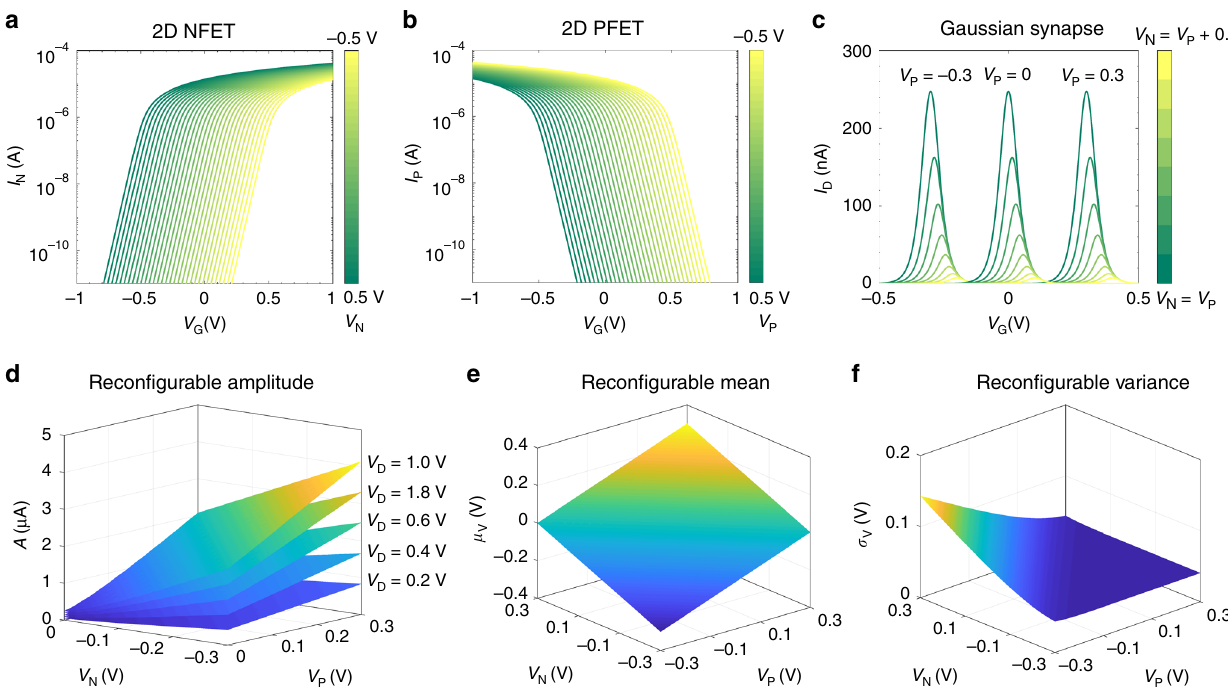
Fig. 3 Scaled Gaussian Synapses. Simulated back-gated transfer characteristics of ( a ) n-type and ( b ) p-type 2D FET for corresponding different top-gate voltages V N and V P , respectively, using the Virtual Source (VS) model. In the VS model, both the subthreshold and the above threshold behavior are captured through a single semi-empirical and phenomenological relationship that describes the transition in channel charge density from weak to strong inversion. c Transfer characteristics, ( d ) amplitude, ( e ) mean, and ( f ) standard deviation of the Gaussian synapse obtained via heterogeneous integration of the n-type and the p-type 2D FETs for different combinations of V N and V P . The following parameters were used for the simulation. L